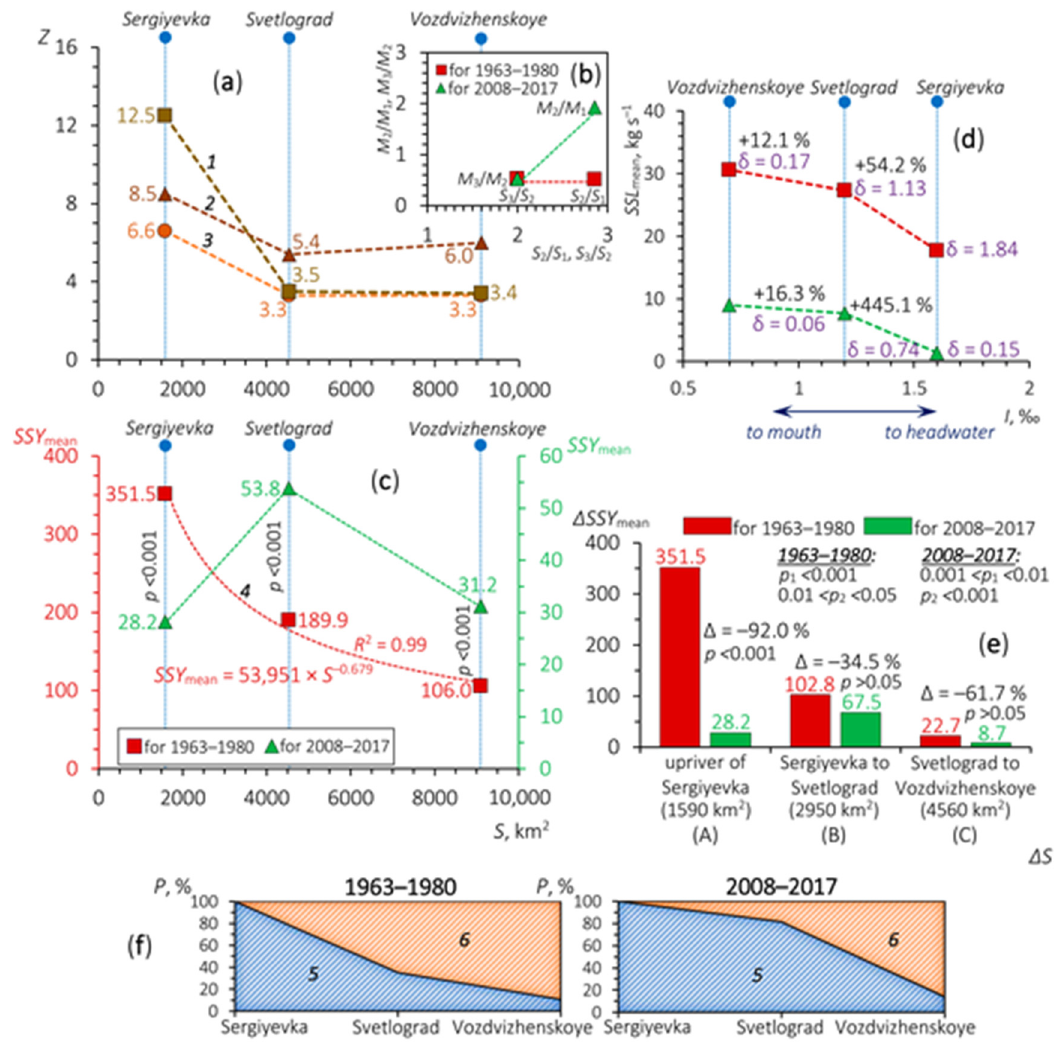
Figure 8. Contemporary long-term changes in some spatiotemporal characteristics of suspended sediment load/yield/con- centration of the Kalaus River at the analyzed hydrological stations (see Figure 1; Table 1). Z —the ratio between 1963–1980 and 2008–2017 (times) for: 1 —mean annual suspended sediment load ( SSL mean ), 2 —mean annual suspended sediment concentration, 3 —maximal (per annum) suspended sediment concentration (based on the data from Figure 6) ( a ); 4 —the power trend line for SSY mean —annual suspended sediment yield (Mg km –2 y –1 ) upriver of the corresponding station during the corresponding monitoring period ( c ) ( M 1 —upriver of Sergiyevka, M 2 —upriver of Svetlograd, M 3 —upriver of Vozdvizhenskoye ( b )); ∆ SSY mean —differential annual suspended sediment yield (Mg km –2 y –1 ) (see Equation (2)) ( e ); S —river basin area ( S 1 —upriver of Sergiyevka, S 2 —upriver of Svetlograd, S 3 —upriver of Vozdvizhenskoye); ∆ S —differential river basin area; ∆ —relative reduction in ∆ SSY mean ; I —mean riverbed gradient upriver of the corresponding station; δ —the ratio of the difference in SSL mean between neighboring hydrological stations (i.e., ∆ SSL mean ) to the river’s length between these stations ( ∆ L ) (for the station at Sergiyevka—between the station and the river’s headwater): δ = ∆ SSL mean / ∆ L , kg s –1 10 km –1 ( d ); the probability of statistically significant difference (the Student’s t -test) between: p —1963–1980 and 2008–